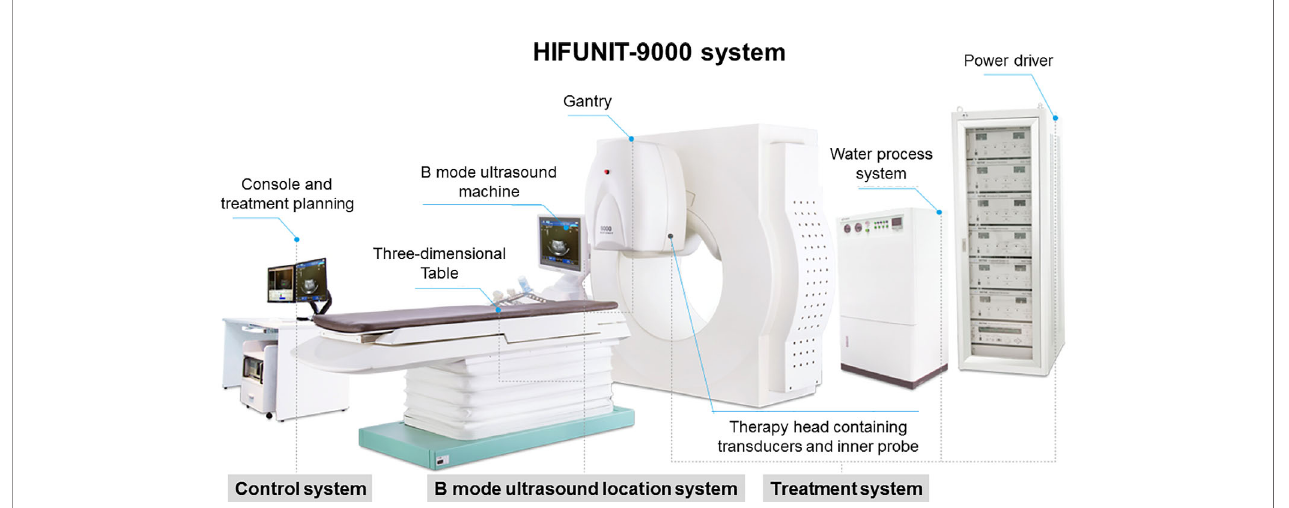
FIGURE 1 | HIFUINT-9000 system. This system consists of three parts: a fi ring system located in a tank fi lled with degassed water, an imaging system consisting of an ultrasound scanner coupled with a stereotaxic localizing arm, and a computer that controls the fi ring sequence and the movement of the fi ring head through a three-dimensional micropositioning